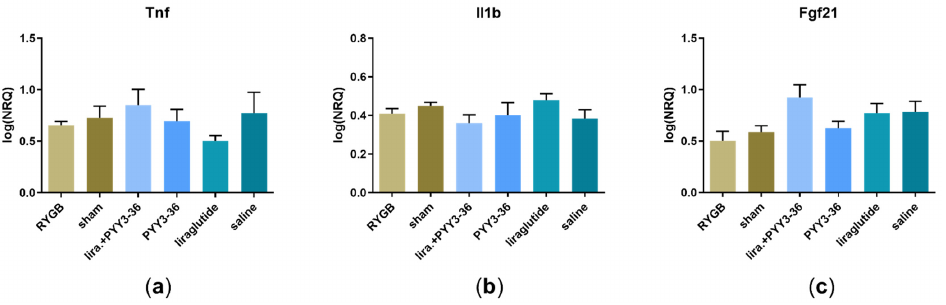
Figure 3. RT-qPCR assessment of the inflammatory markers in liver samples ( a ) Tnf (RYGB: n = 8; sham: n = 4; liraglutide+PYY 3-36 : n = 3; PYY 3-36 : n = 3; liraglutide: n = 3; saline: n = 2), ( b ) Il1b (RYGB: n = 8; sham: n = 8; liraglutide+PYY 3-36 : n = 4; PYY 3-36 : n = 4; liraglutide: n = 5; saline: n = 3) and ( c ) Fgf21 (RYGB: n = 8; sham: n = 9; liraglutide+PYY 3-36 : n = 5; PYY 3-36 : n = 5; liraglutide: n = 4; saline: n = 3) as log-transformed normalized relative quantities (NRQs). Data are presented as mean ± standard error of the mean.